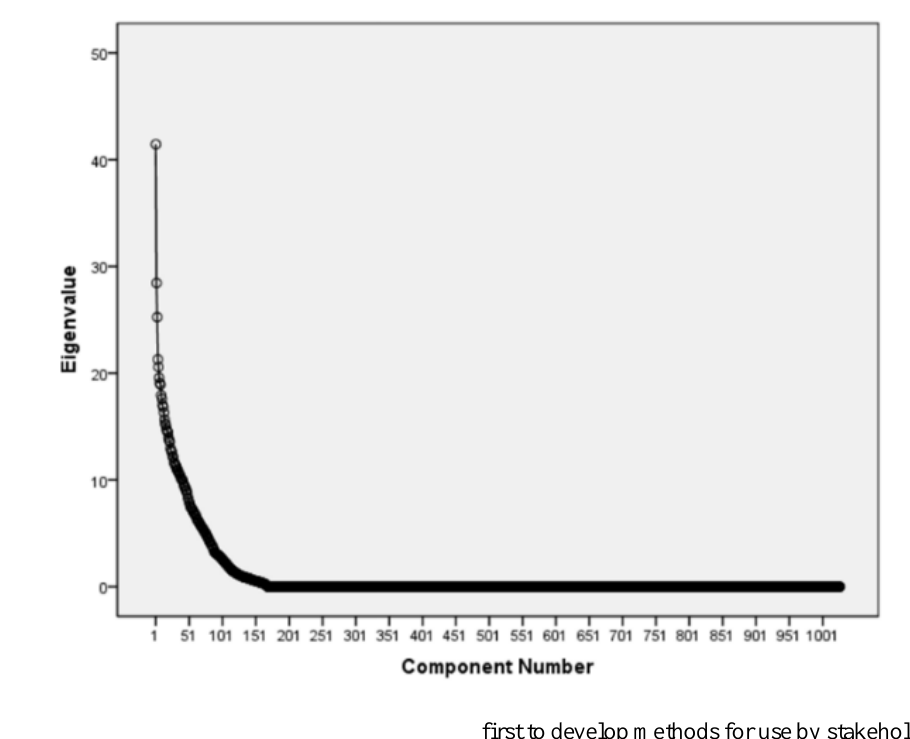
Figure 3. Scree plot of extracted components and their corresponding eigenvalues. Components with Eigenvalues <1 were excluded revealing 129